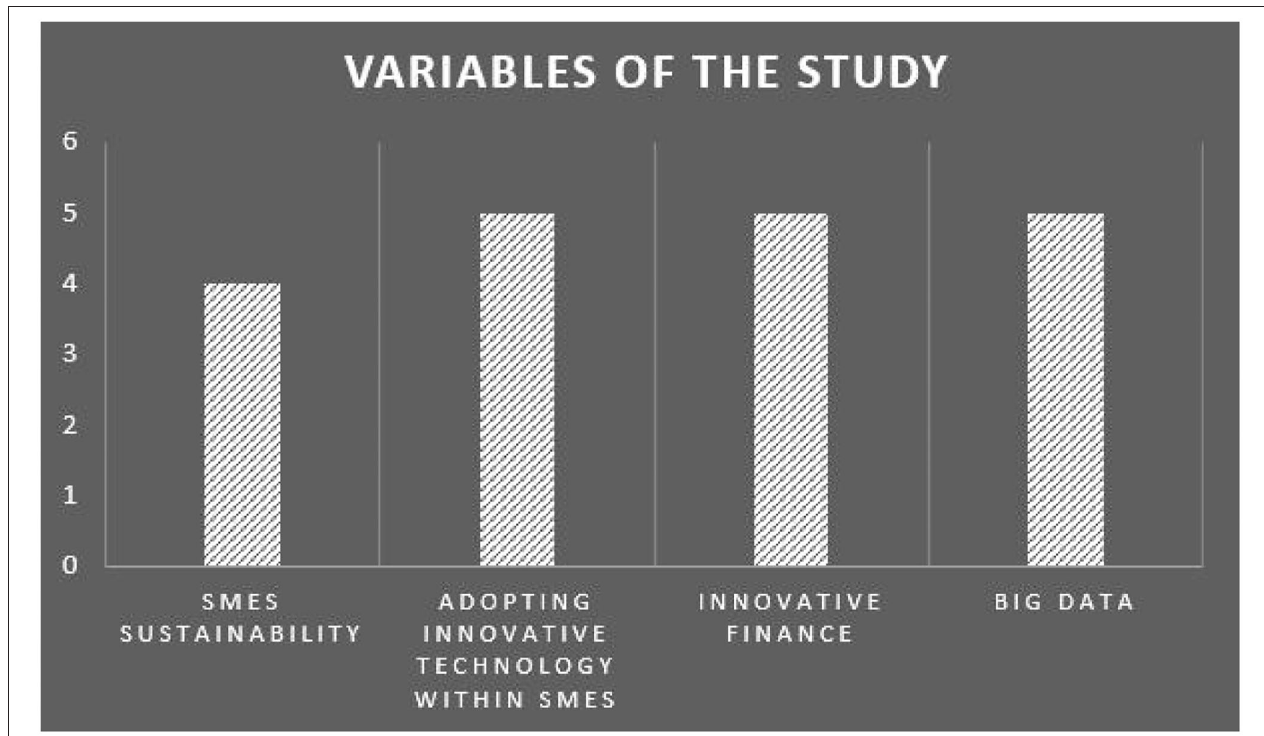
FIGURE 1 | Graphical representation of the identified variables in the